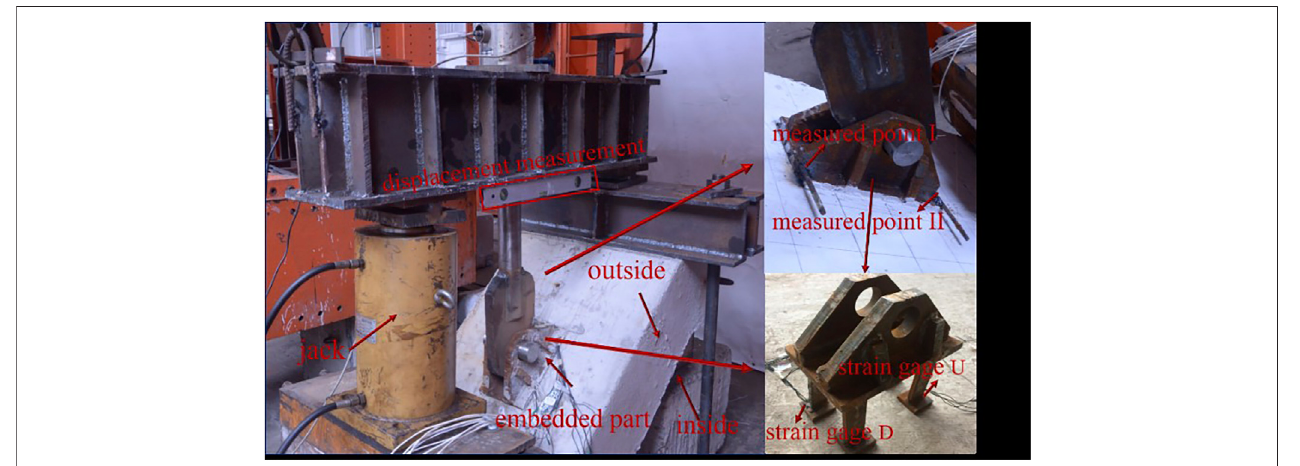
FIGURE 6 | Layout of strain stages and displacement measurement.